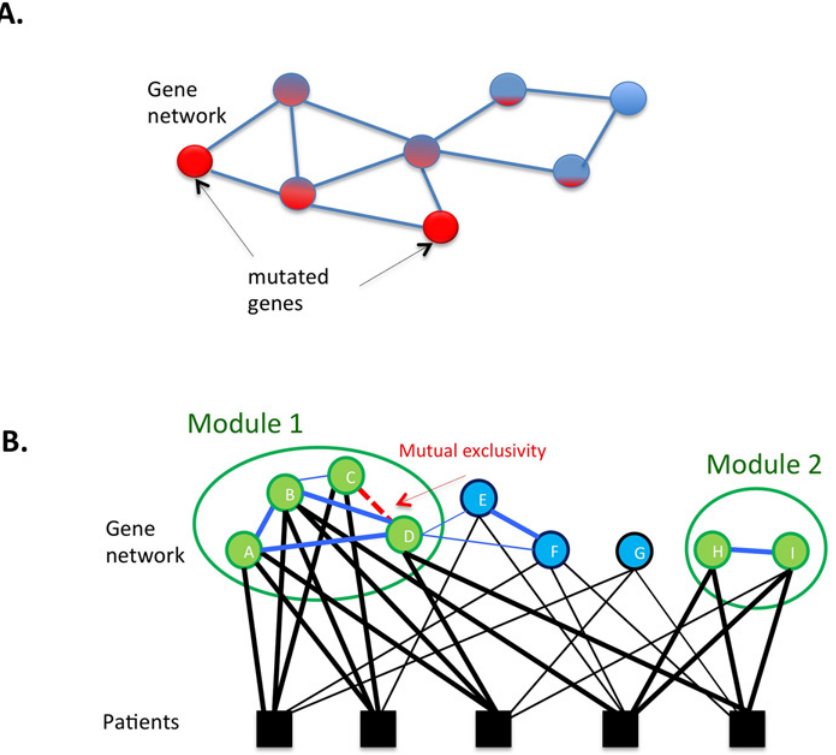
Fig 1. Illustrations of how gene networks can be used in cancer data analysis. A) Information propagation approach: the information about mutated genes (in red) is propagated to their neighborhood through interactions, helping to identify significantly affected subnetworks. The level of redness of a node indicates how likely the gene is affected. B) Module Cover approach finds the minimum cost subnetworks so that each patient is covered by at least k mutated genes. The edges in the gene interaction network (blue edges) may be weighted based on interaction confidence or mutual exclusivity. For example, the patients covered by gene C and D are mutually exclusive. There is an edge between a gene and a patient if the gene is mutated in the patient (black edges). The figure shows an example where two modules are selected, covering each patient at least three times (k = 3). The green nodes are selected genes, and the thick edges indicate the selected interactions or gene-patient